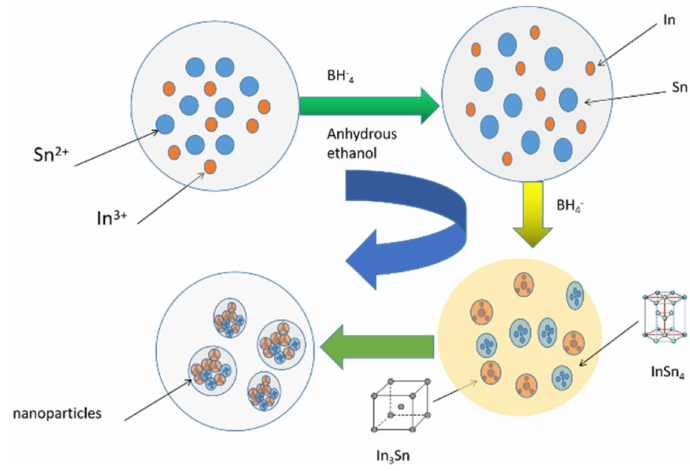
Figure 5. Diagram of the formation process of indium-tin